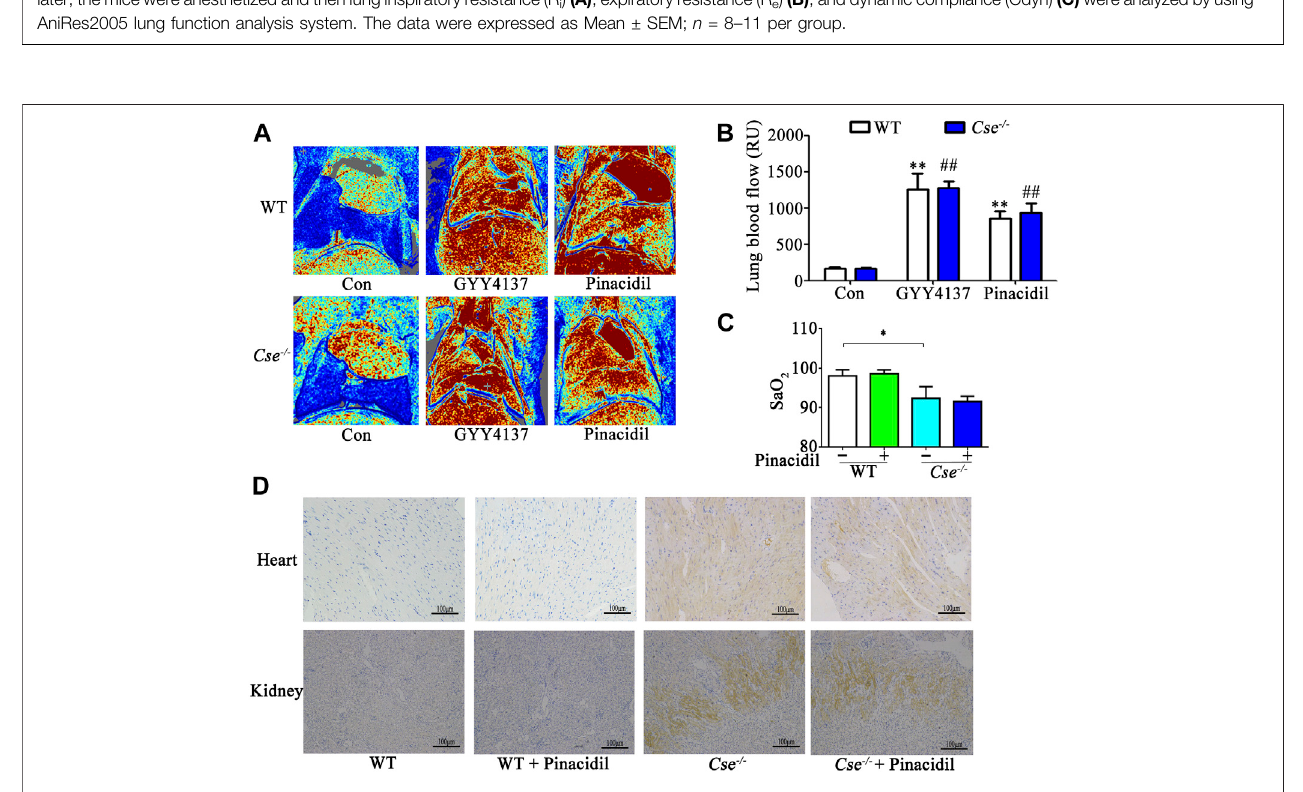
FIGURE 3 | Increased lung blood fl ow does not affect SaO 2 and tissue hypoxia in kidney and heart. WT and Cse -/- mice were administered with saline, pinacidil (2.8 μ mol/kg), orGYY4137 (50mg/kg). Twenty-fourhourslater, themicewereanesthetizedand thenlung blood fl owand SaO 2 wasevaluated.Somemice wereinjected withHypoxyprobesolution,thenthemiceweresacri fi cedat30minafterinjection.Biopsiesofkidneysandheartwere fi xed.Hypoxyprobesignalsweredetectedbyusing immunocytochemistry analysis. ( A) , representative LDI analysis of lung blood fl ow. (B) , cumulative data of lung blood fl ow in the mice. Data were expressed as Mean ± SEM; n (cid:2) 6 – 10 per group; ** p < 0.01 vs. WT, ## p < 0.01 vs. Cse -/- . (C), SaO 2 level in WT and Cse -/- mice with saline or pinacidil treatment. Data were expressed as Mean ± SEM; n (cid:2) 8 – 9 per group; * p < 0.05. (D), representative images of Hypoxyprobe signals in the heart and kidneys in WT and Cse -/- mice with saline or pinacidil